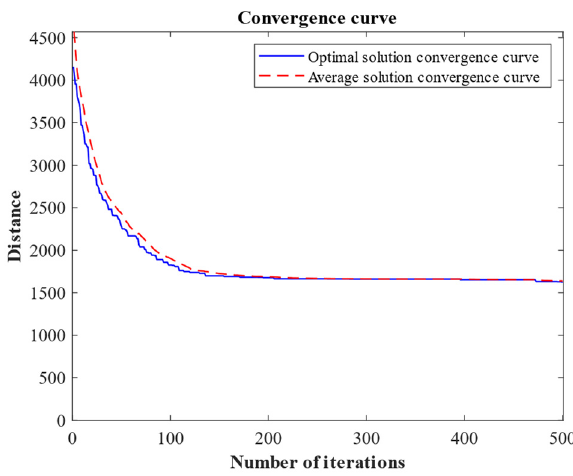
Figure 7. The optimization convergence curve of the cuckoo search algorithm when the number of locations to be visited is 30.